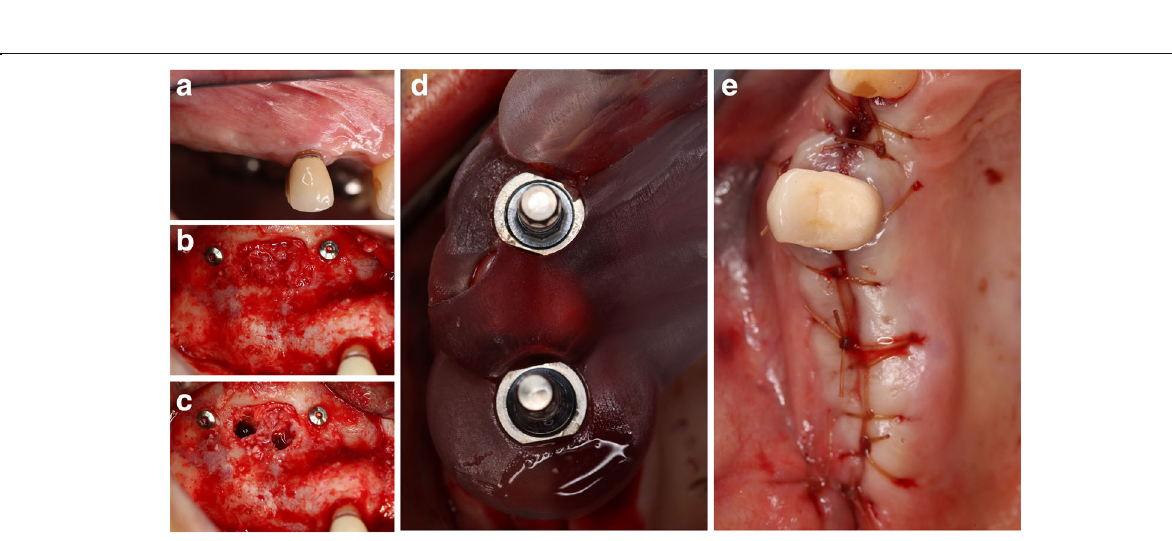
Fig. 5 a 4 months of healing before implant placement surgery. b Full-thickness flap reflection to retrieve the core samples and tacks before implant placement. c Core samples retrieved from anterior and posterior sinus regions. d Fully guided implant placements using the surgical guide. e Tension-free primary closure after implant